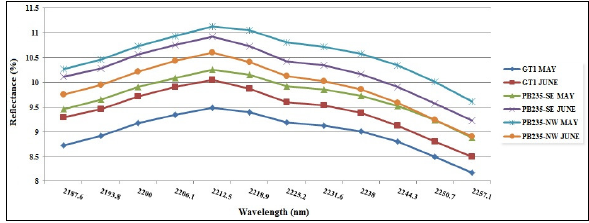
Figure 17. Spectral behaviour in canopy scale in the region 2,220nm of the Rubber trees stands: GT1, PB235-SE and